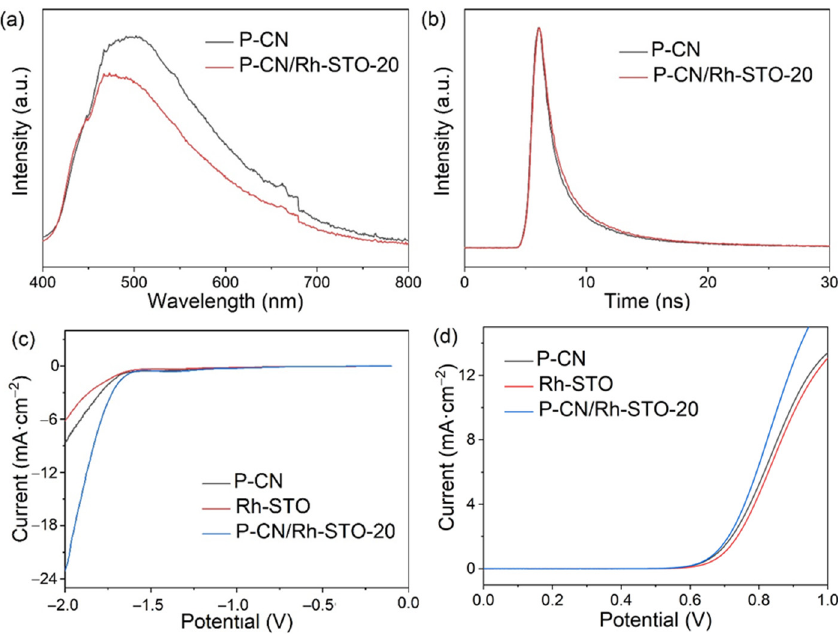
Figure 5. ( a ) Steady-state photoluminescence spectra and ( b ) time-resolved photoluminescence decay spectra of P-CN and P-CN/Rh-STO-20; Linear voltammetric scanning curve of ( c ) electrocatalytic hydrogen evolution reaction and ( d ) electrocatalytic triethanolamine oxidation over P-CN, Rh-STO, and P-CN/Rh-STO-20, respectively.